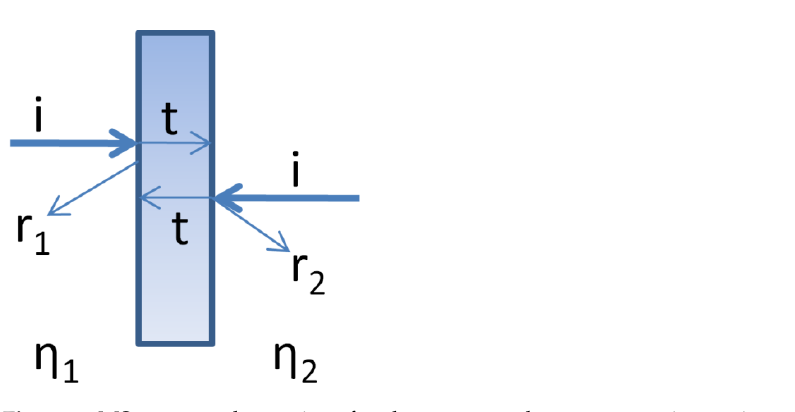
Figure 2. MS structured as an interface between two homogeneous isotropic media. For incident oblique waves, if MS has non-zero electromagnetic susceptibility, sus- ceptibilities χ ee , χ em , and χ mm are independent of the incident angles. In this case, three equivalent circuit parameters Z 1 , Z 2, and admittance Y can be represented in terms of scalar susceptibilities